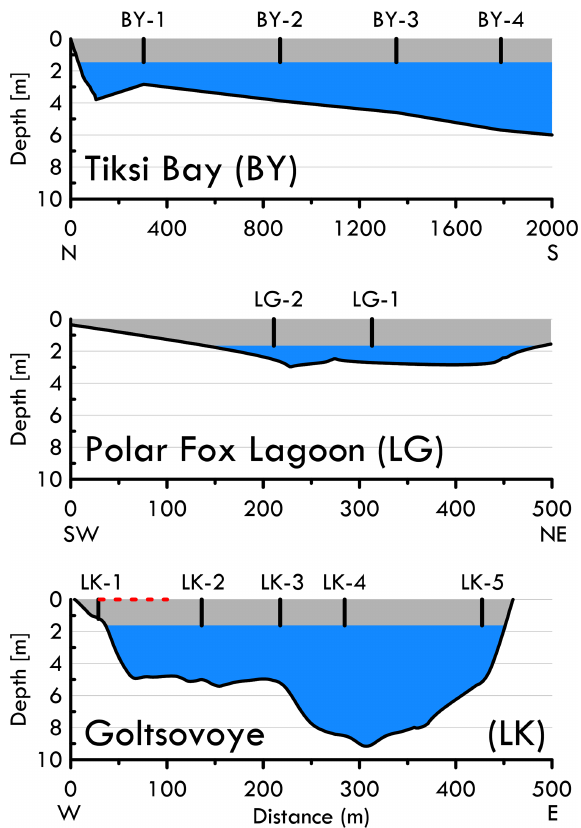
Figure 2. Cross sections of the bathymetry of the Tiksi Bay (BY) profile (N to S), Polar Fox Lagoon (LG) from southwest to north- east and Goltsovoye Lake (LK) along the coring transect (W to E). Positions of the ice cores are indicated as numbered vertical lines in the ice layer (grey shading shows mean water body ice thickness), and the water column below the ice is indicated in blue. The posi- tion of the bubble transect at Goltsovoye Lake is represented with a dashed red